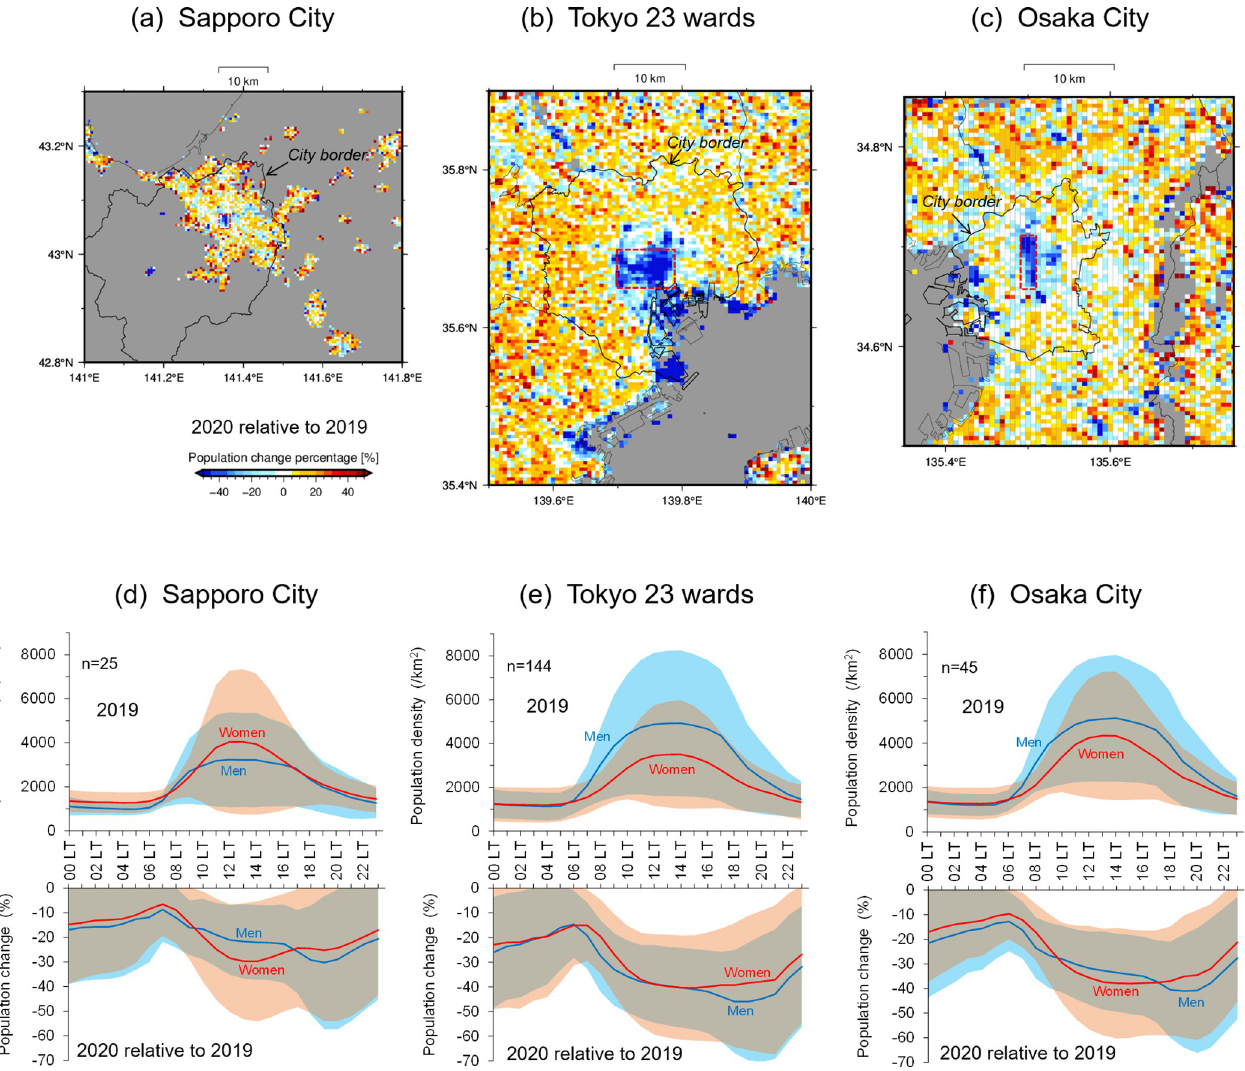
Fig 7. Elderly (60s and 70s) population change (%) averaged during an inhibited behaviour period in 2020 relative to 2019 at 12 LT. Spatial distributions obtained from mobile terminal information with a mesh of 1-km squares in (a) Sapporo, (b) Tokyo, and (c) Osaka. Red broken rectangles represent the central urban area analysed in (d)–(f). Hourly variations of population density per 1-km square at the upper panels of (d)–(f) and population change (%) in 2020 relative to 2019 at the lower panels of (d)–(f). Results averaged at the area depicted by the red broken rectangle in (a)–(c) (lines) and their standard deviations (tones) for men (blue) and women (red) in (d) Sapporo, (e) Tokyo, and (f) Osaka. These were averaged during an inhibited behaviour period from 17 April to 14 May in 2020.